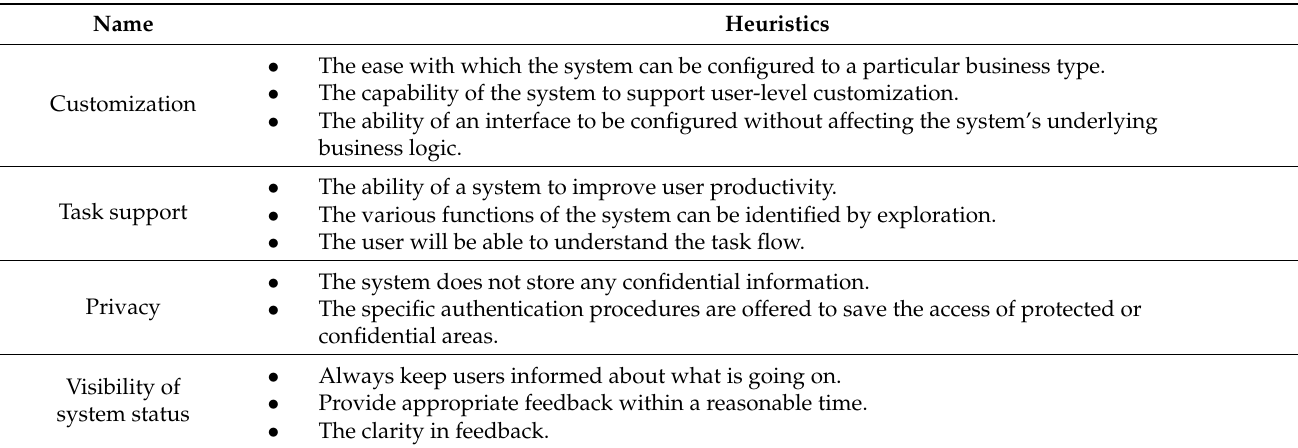
Table 2. The customized heuristic of ERP